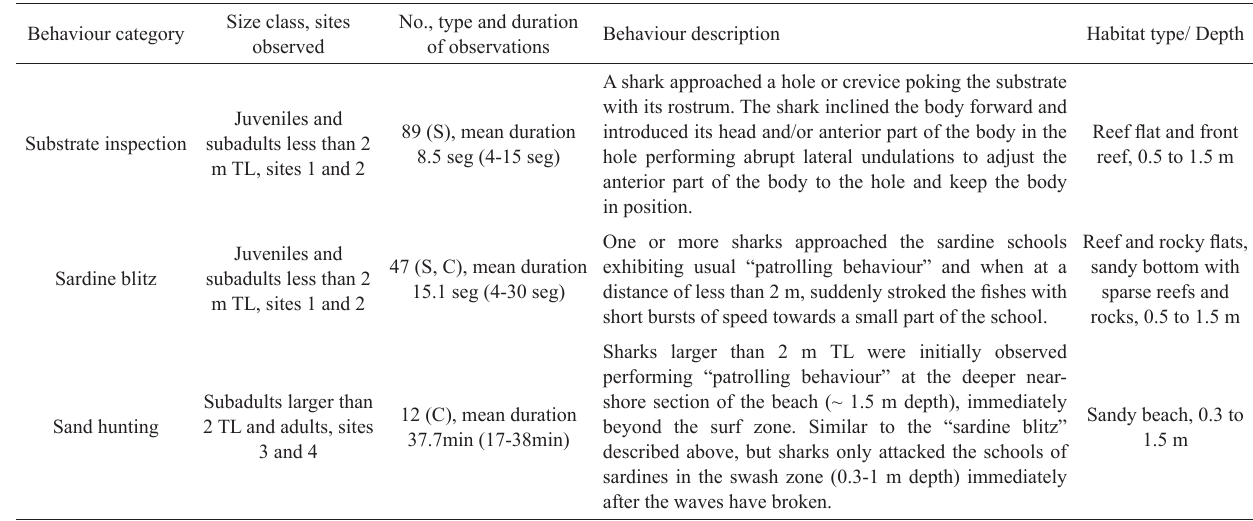
Fig. 2. Percentage of occurrence of hunting behaviours of Negaprion brevirostris per a . site, b., c . body size and d . time of the day in Fernando de Noronha Archipelago. I: substrate inspection; SB: sardine blitz; SF: sand fishing; M: morning, A: afternoon; J: juvenile; SA: subadult; A: adult. Tab. 2. Ethogram of snorkeling (S) and cliff-top (C) observed behaviours of Negaprion brevirostris in Fernando de Noronha Archipelago, Brazil (see Fig. 1 for location of